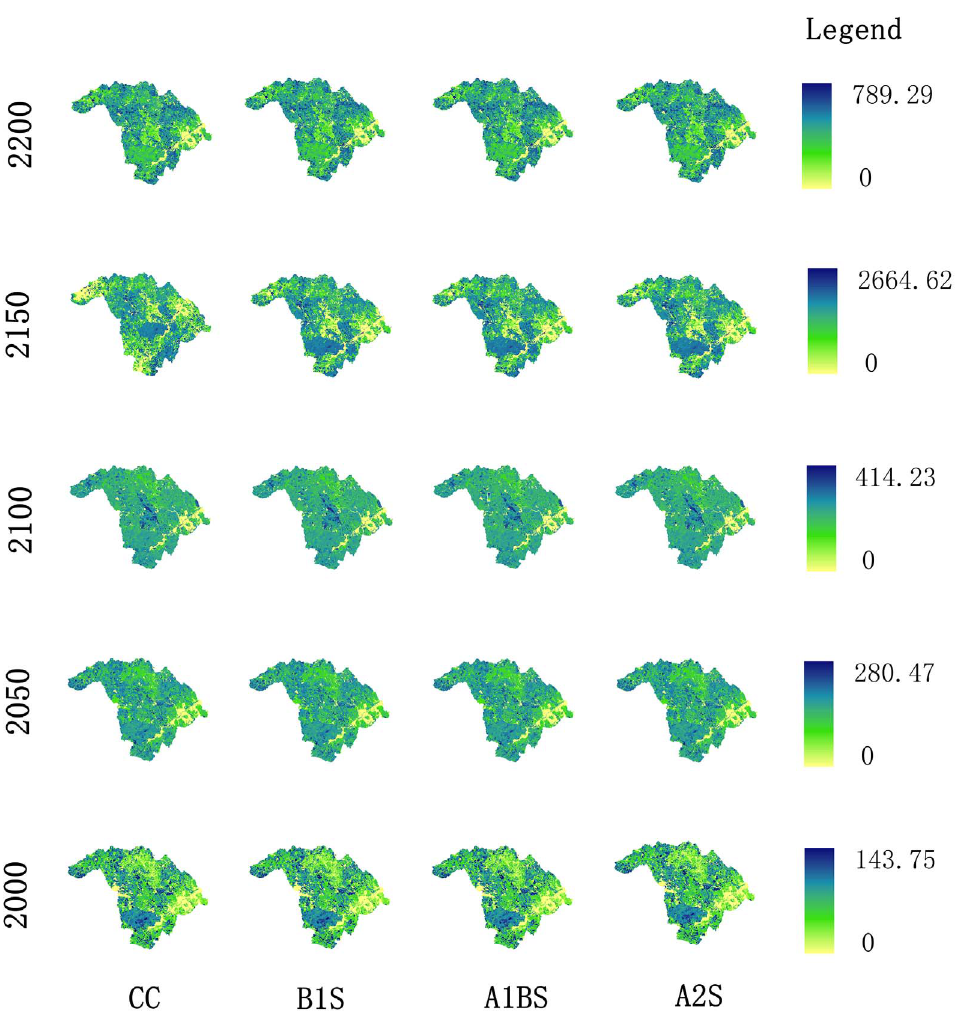
Figure 7. The spatial distribution of forest total biomass under different climates. CC: Current climate, B1S: B1 scenario, A1B: A1B scenario, A2: A2 scenario. Unit: t ha 2 1 .